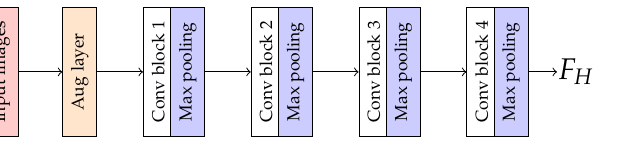
Figure 7. The illustration of an augmented layer in the proposed network